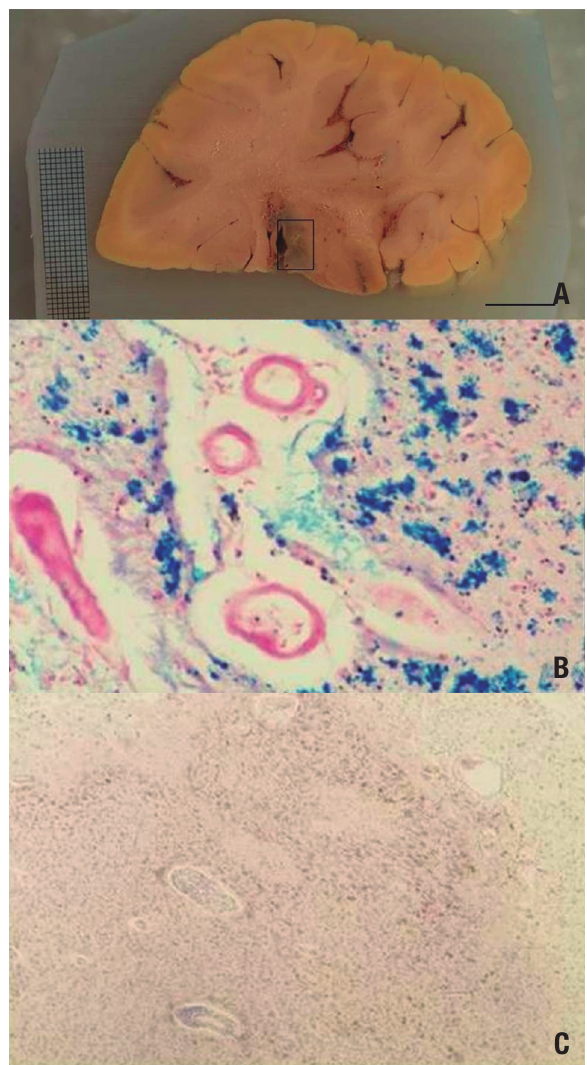
Figure 2. Hemorrhagic infarcts. [A] Coronal section across the thalamus. The boxed area encompasses an hemorrhagic infarct. Note how the tissue color is darker at this site due to hemosiderin. [B] Histological slide of the infarcted area stained for iron. The blue staining represents iron deposits, an indirect marker of bleeding. [C] Histological slide of the infarcted area stained with HE. The whole area is saturated by hemosiderin (in